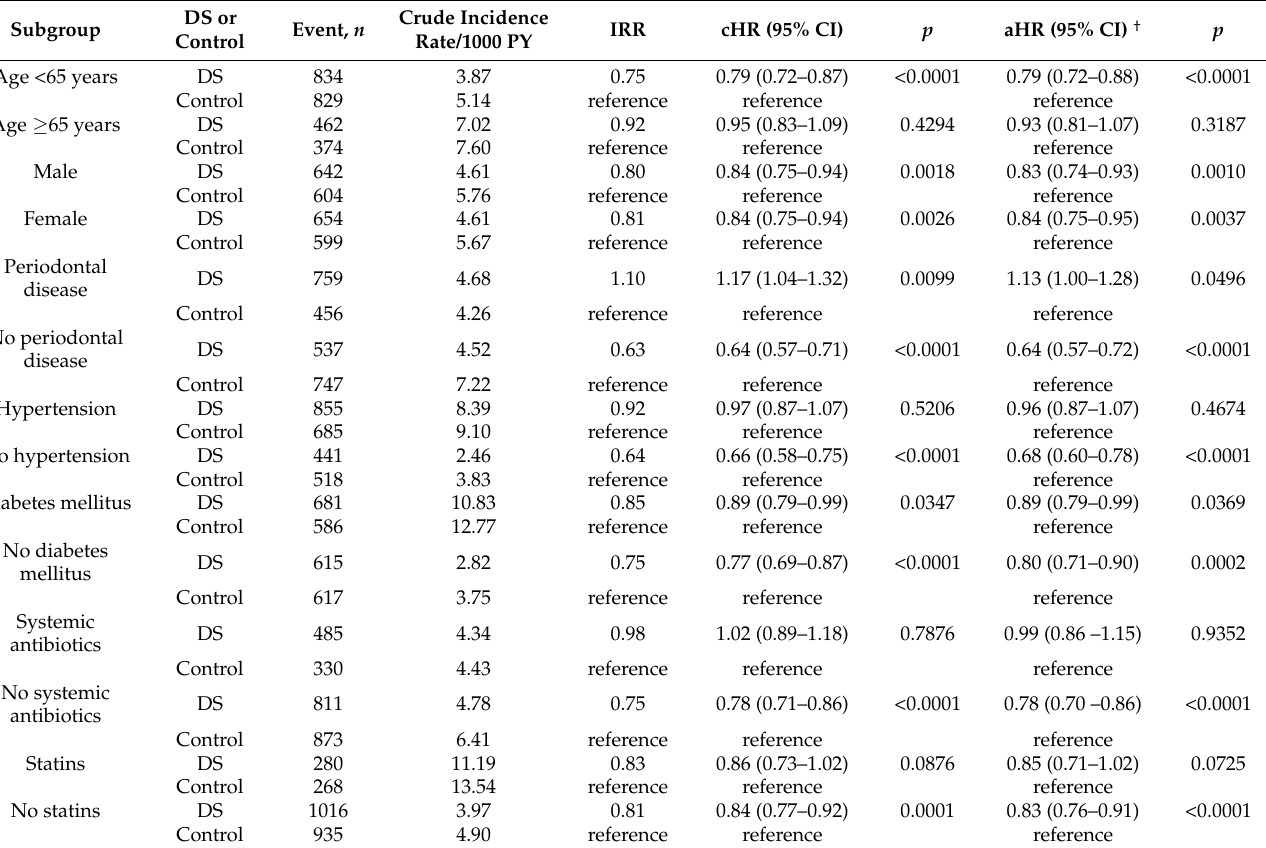
Table 4. Subgroup analysis for the risk of ESRD, associated with dental scaling